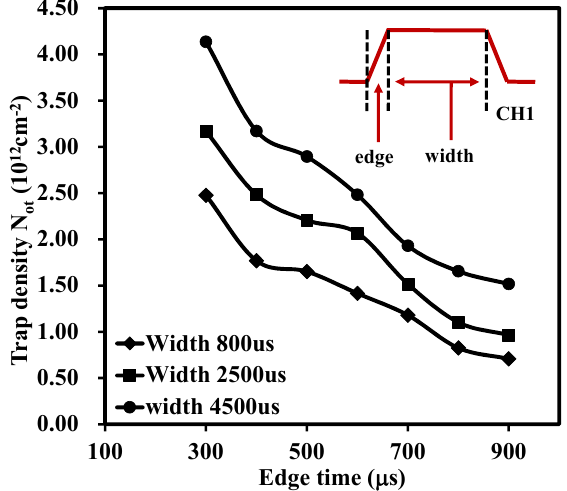
Figure 4. Variation of N ot versus edge time with different stress time (the pulse width) for LaZrO x . The length of stress time is controlled by the width of the pulse. The longer stress time can induce more traps in the oxide, in turn, the increase of N ot . The thickness of the device under test was about 22